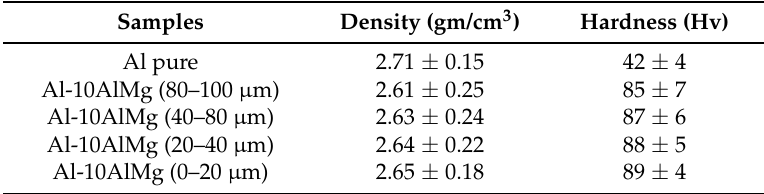
Figure 2. SEM micrographs for the consolidated composites with 10 vol.% of Mg-Al reinforcement with classified particle size ( a ) 80–100 µm; ( b ) 40–80 µm; ( c ) 20–40 µm and ( d ) 0–20 µm. Table 1. Shows the density and hardness of the extruded